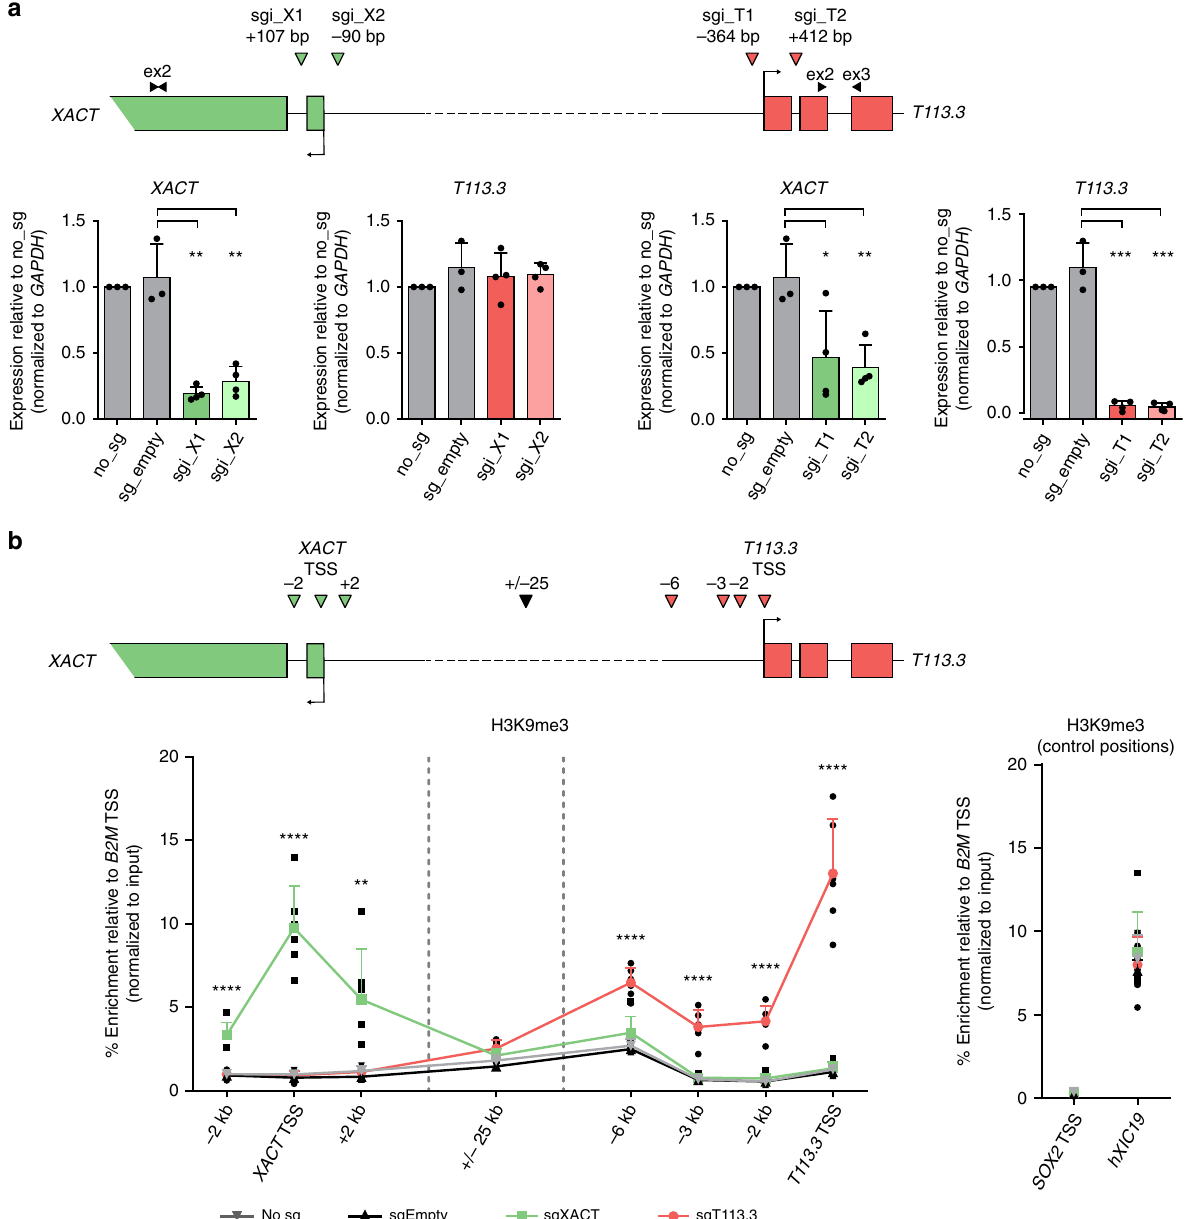
Fig. 3 Transcription of T113.3 regulates the expression of XACT in hESCs. a The top scheme depicts the CRISPRi strategy used to target the XACT and T113.3 promoters, with the positions of the two sgRNAs (colored arrows) and primer pairs used to measure the transcript levels of each gene (black arrows). Quanti fi cation of the global RNA levels of XACT and T113.3 by RT-qPCR upon XACT CRISPRi (left bar charts) and T113.3 CRISPRi (right bar charts). Error bars represent the SD of at least four different passages of hESCs infected with guides targeting either XACT or T113.3 . b ChIP-qPCR analysis of H3K9me3 enrichment across the XACT / T113.3 locus upon XACT CRISPRi (green squares) or T113.3 CRISPRi (red circles) in hESCs. The positions analyzed are indicated in the scheme with arrows. ChIP-qPCR data for untransfected cells (gray inverted triangles) and cells transfected with a vector without a sgRNA (black triangles) is also shown. Right graph represents the relative enrichment of H3K9me3 in control positions ( SOX2 TSS and hXIC19). Error bars represent the SD of three passages of each of two independent hESC lines infected with different guides targeting either XACT or T113.3 ( n = 6). * P -values < 0.05, ** P -values < 0.01, *** P -values < 0.001, and **** P -values < 0.0001. Statistical signi fi cances were determined using a one-way ANOVA with